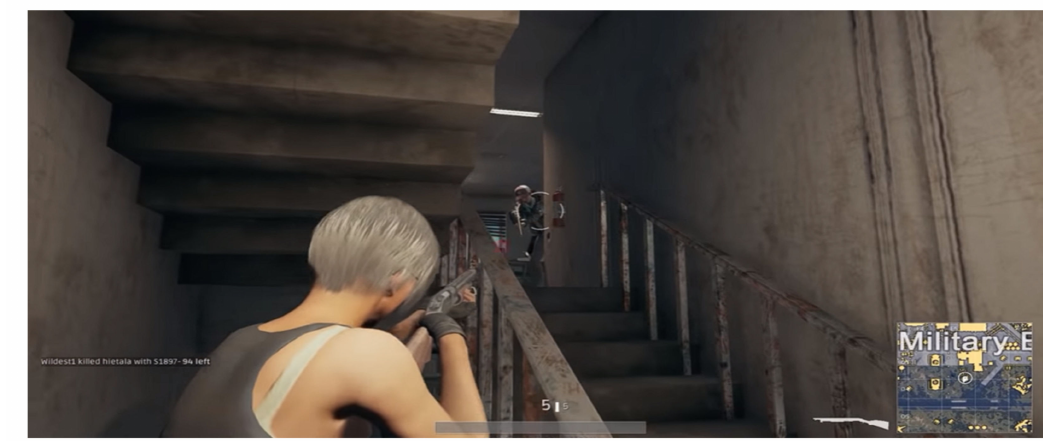
Figure 5. A duel in